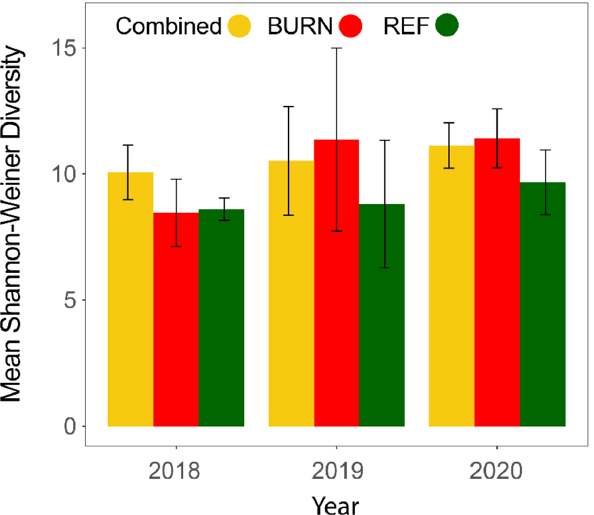
Figure 3. Total number of insects at both study sites for each study year.